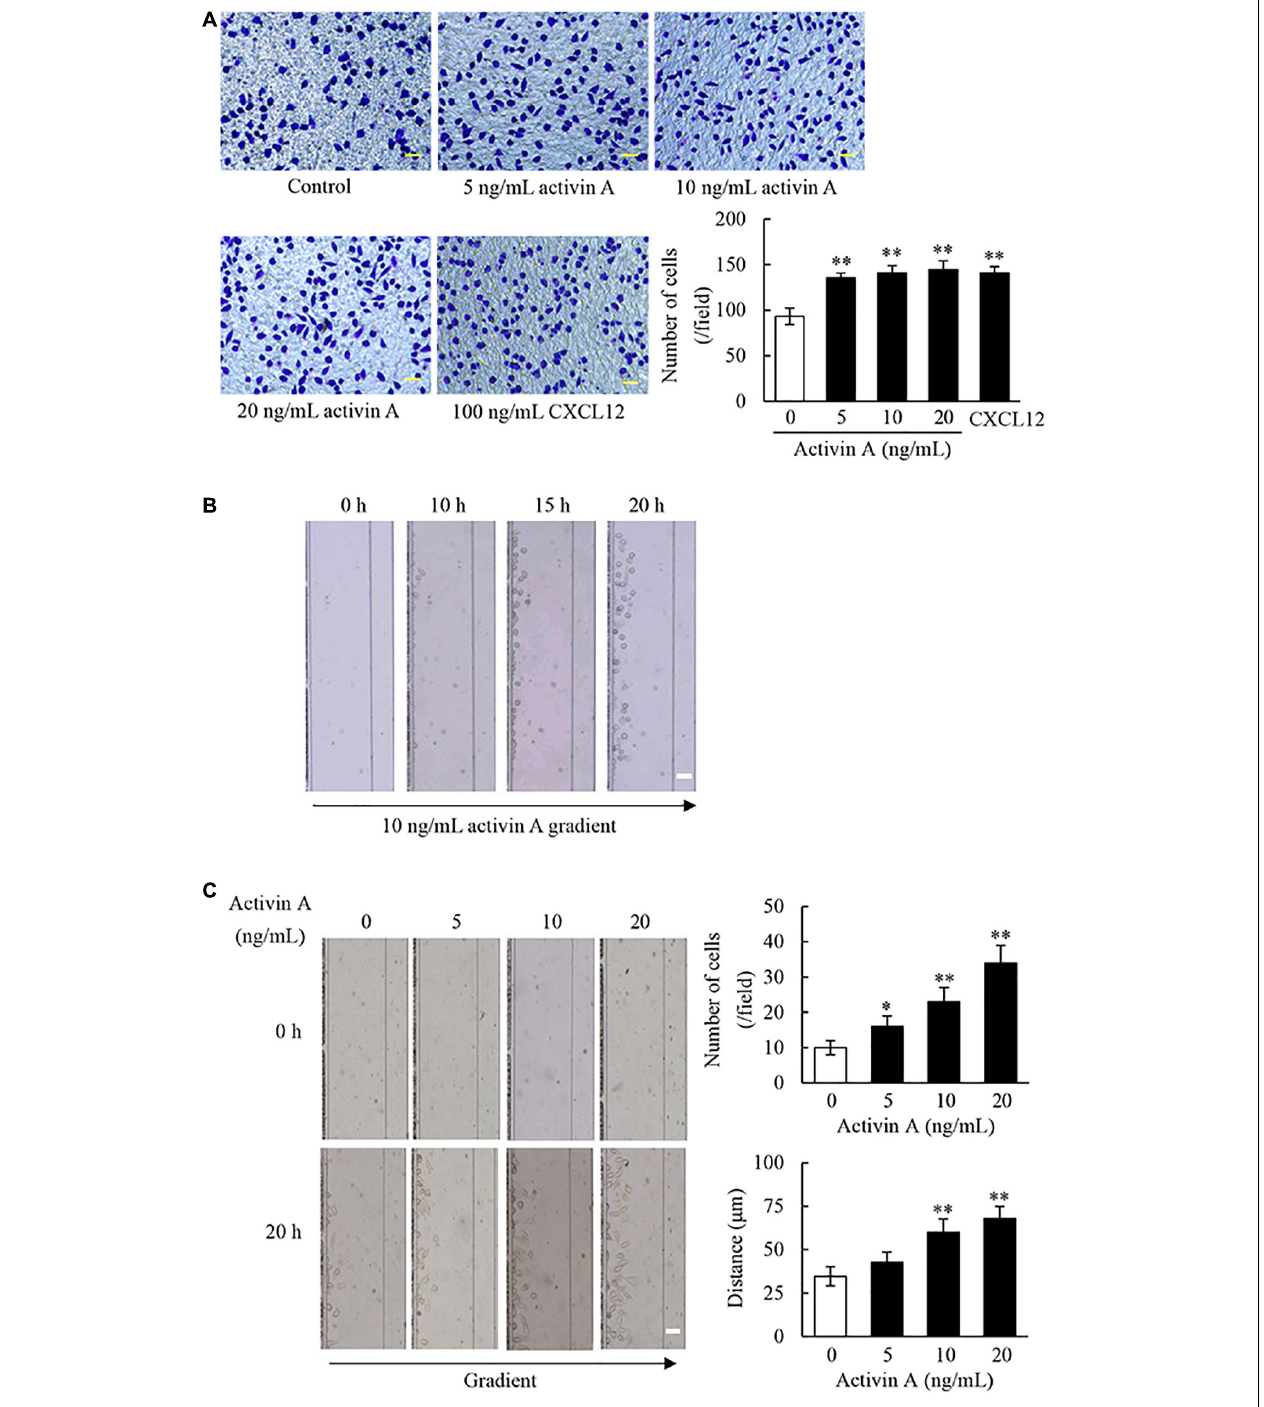
FIGURE 2 | Effect of activin A on migration of L929 cells. (A) The chemotactic migration of L929 cells to activin A (0–20 ng/mL) and CXCL12 (100 ng/mL) was analyzed by transwell chamber assay. Cell that passed through porous membrane of the chamber were stained with Giemsa. Scale bar = 50 µ m. The graph showed the average number of Giemsa-stained cells in three separate experiments. ∗∗ P < 0.01 compared with 0 ng/mL control group. (B) Images of L929 cells migration toward 10 ng/mL activin A gradient at different times were taken in the microfluidic device. Scale bar = 50 µ m. (C) Images of L929 cells migration toward different concentrations activin A gradient (0–20 ng/mL) were taken in the microfluidic device at 0 and 20 h, respectively. Scale bar = 50 µ m. The graph showed the average number and distance of migrating cells in the same size fields of the microfluidic device in three separate experiments. ∗ P < 0.05 and ∗∗ P < 0.01 compared with 0 ng/mL control